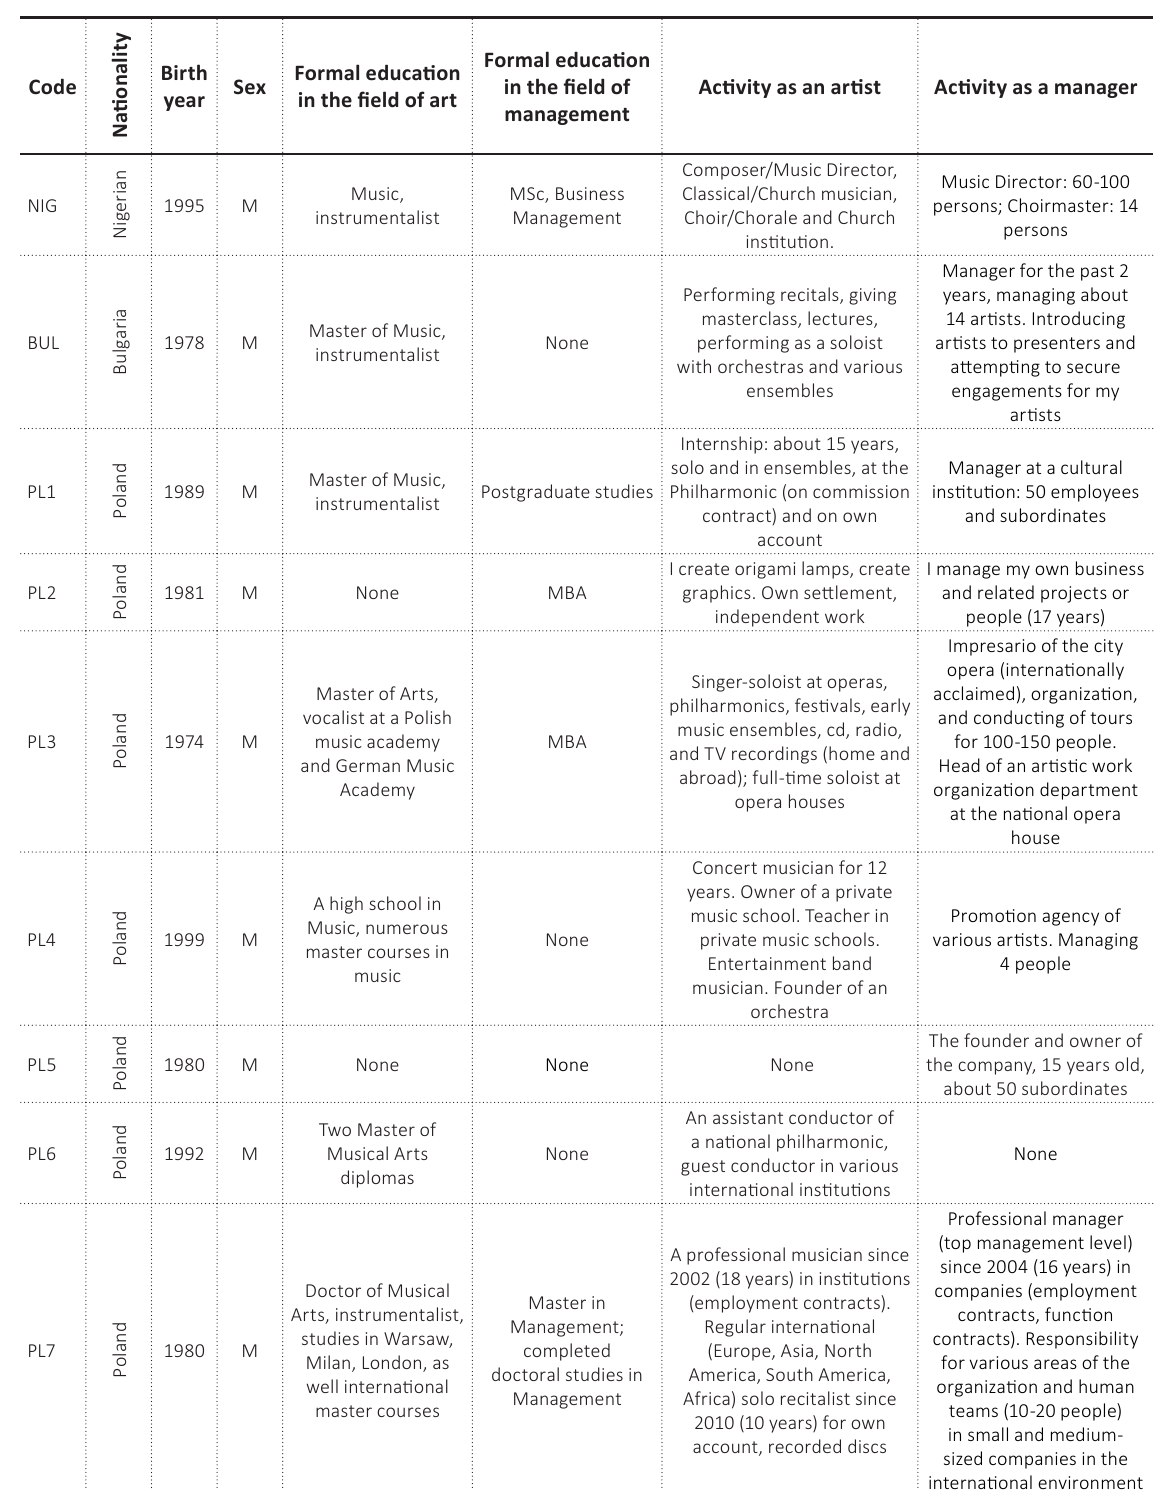
Table A1 (cont.). Description of the research